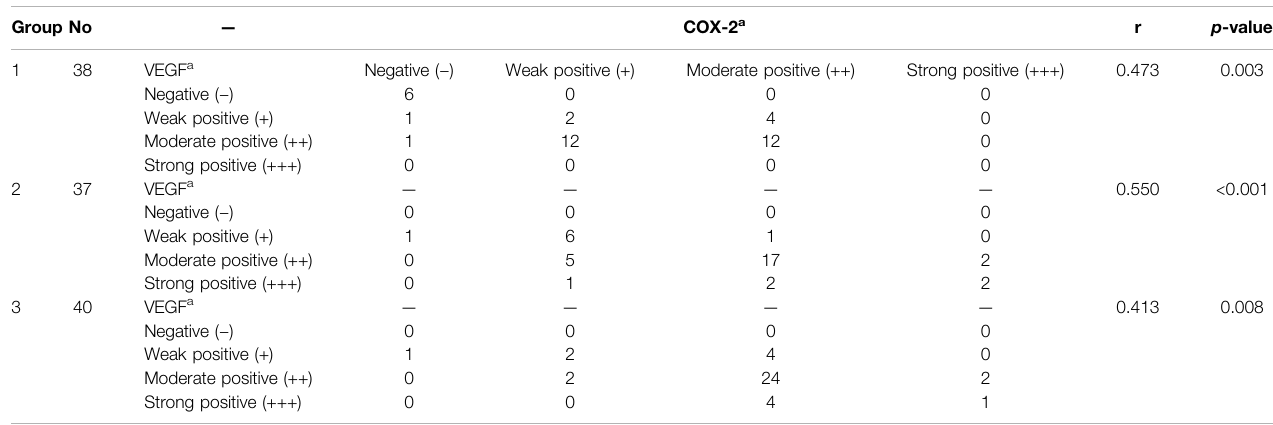
TABLE 3 | Correlations between levels of VEGF and COX-2 expression in primary pterygium patients. Group